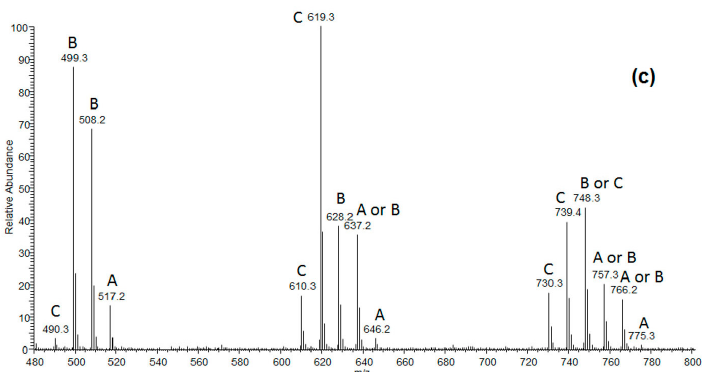
Figure 4. ESI-MS spectrum (in positive-ion mode) of the tyrosol- γ -PGA conjugates obtained by esterification reaction between γ -PGA and tyrosol ( a ) and spectral expansion in the range m / z 840–1040 ( b ) and m / z 480–800 ( c ).